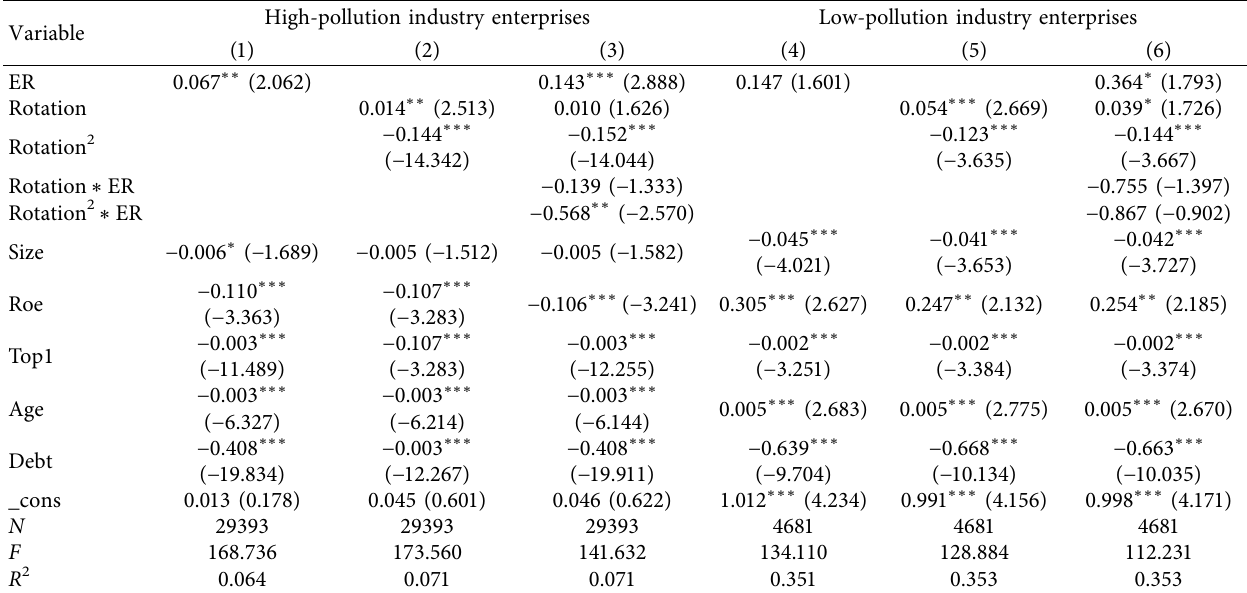
Table 11: Regression results of impact of environmental regulation and official communication on innovation capability of different types of